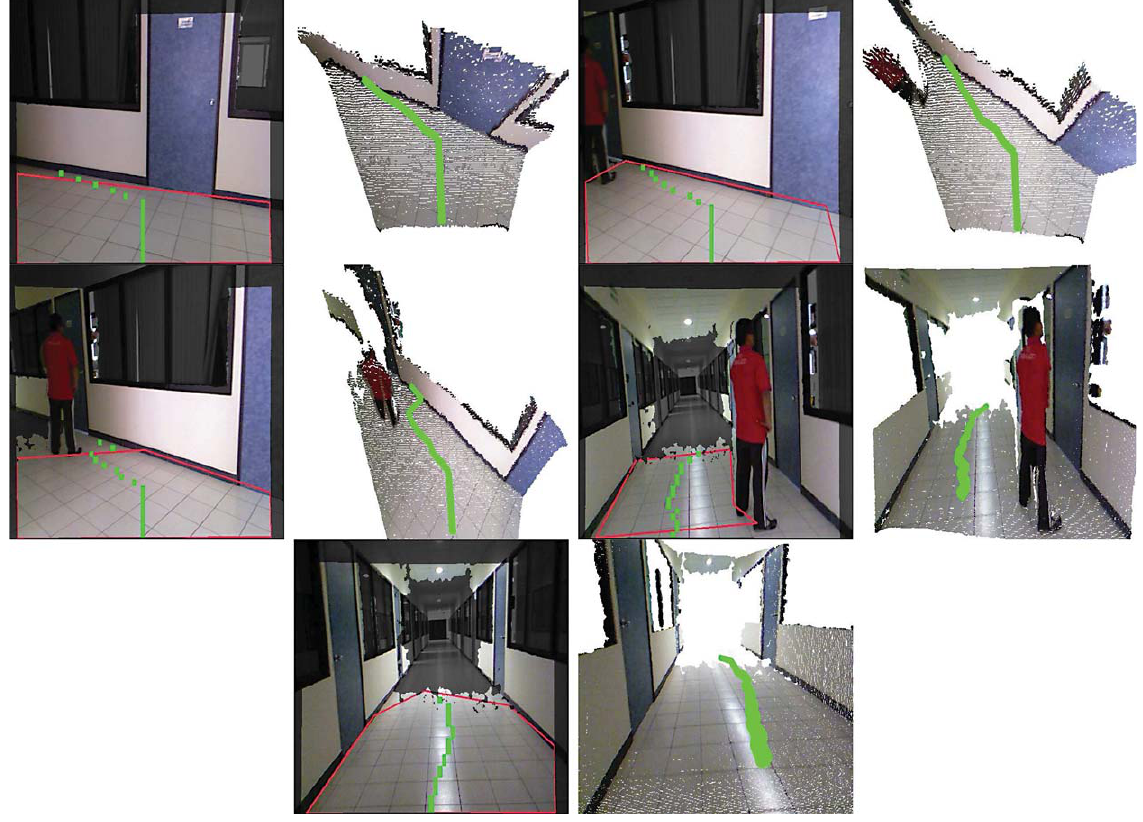
Fig. 21. Sequence of navigation towards an office: planning paths on the floor detected. The path is drawn on the images and also on the 3D virtual-world representation.